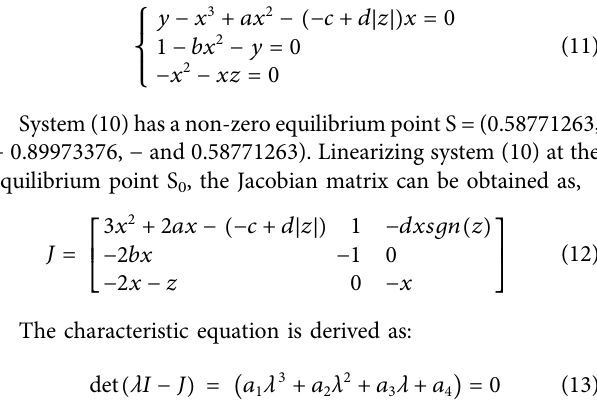
Frontiers in Physics |